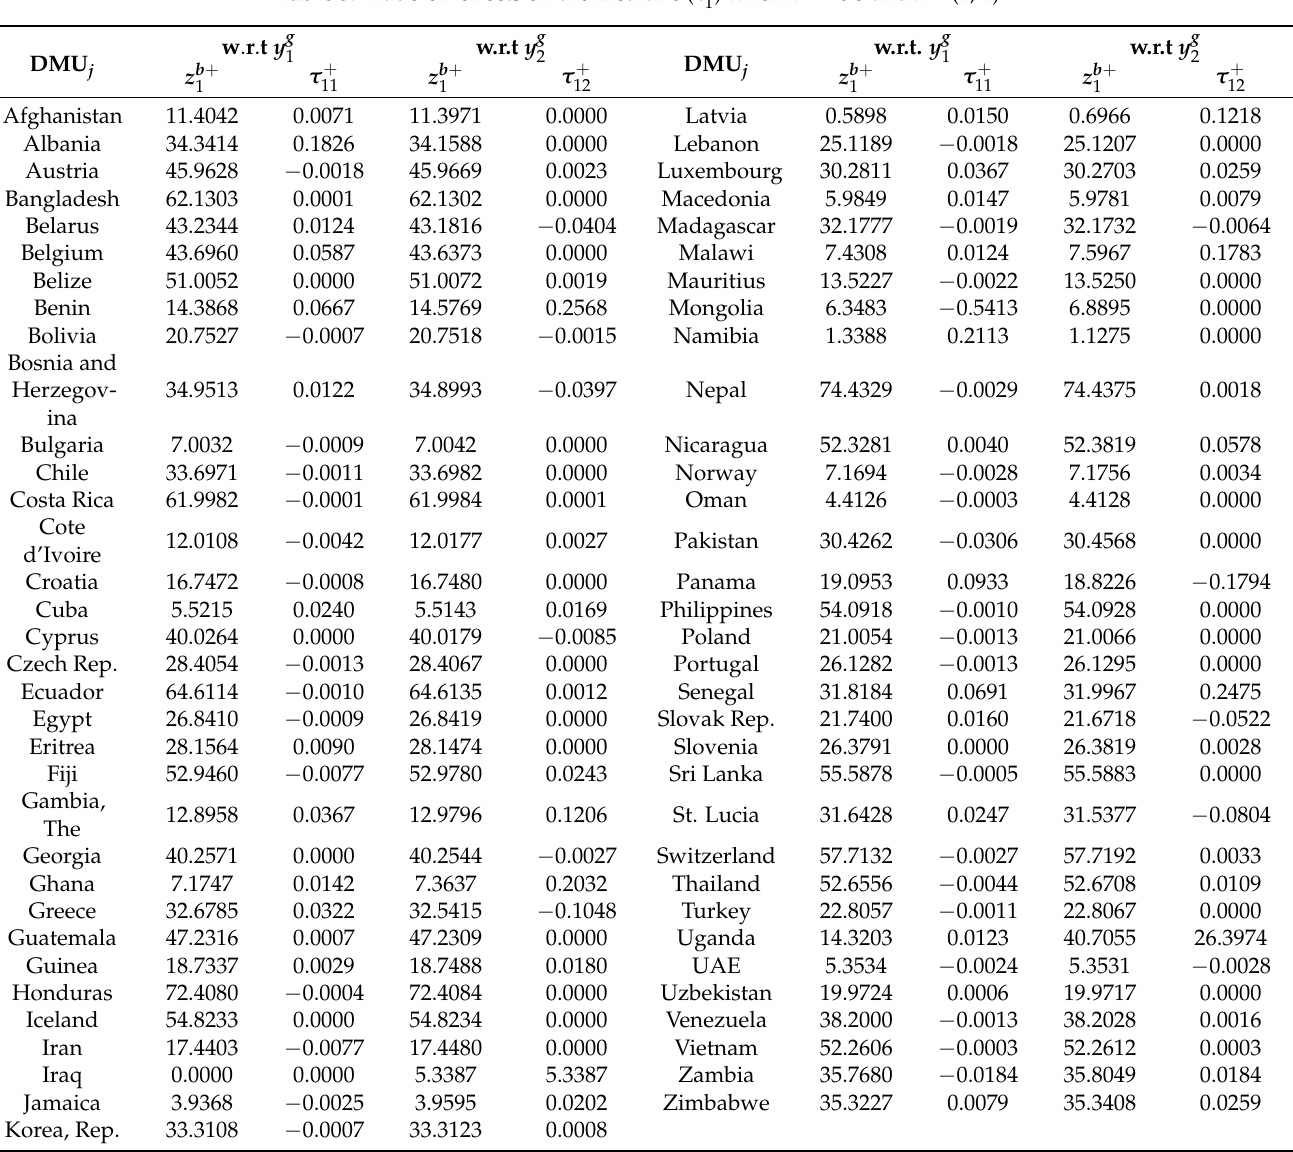
Table 5. Trade-off effects on the methane ( z b